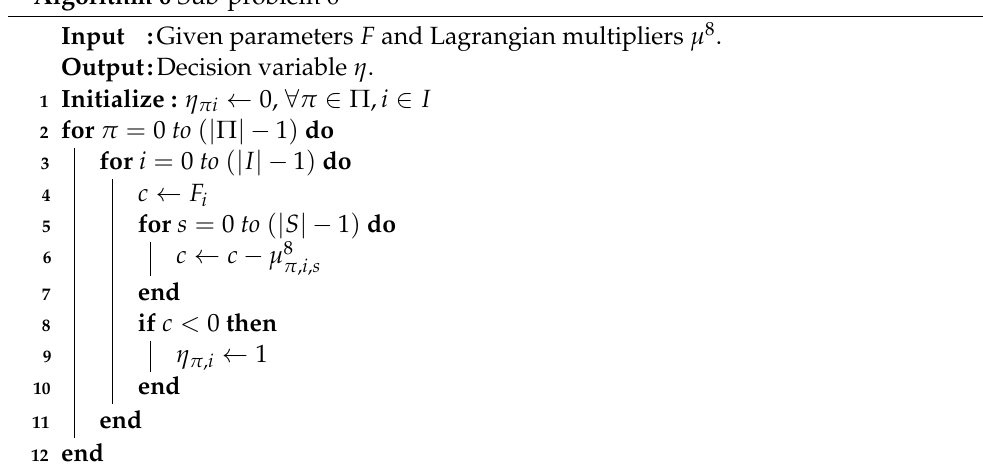
Algorithm 6 Sub-problem 6